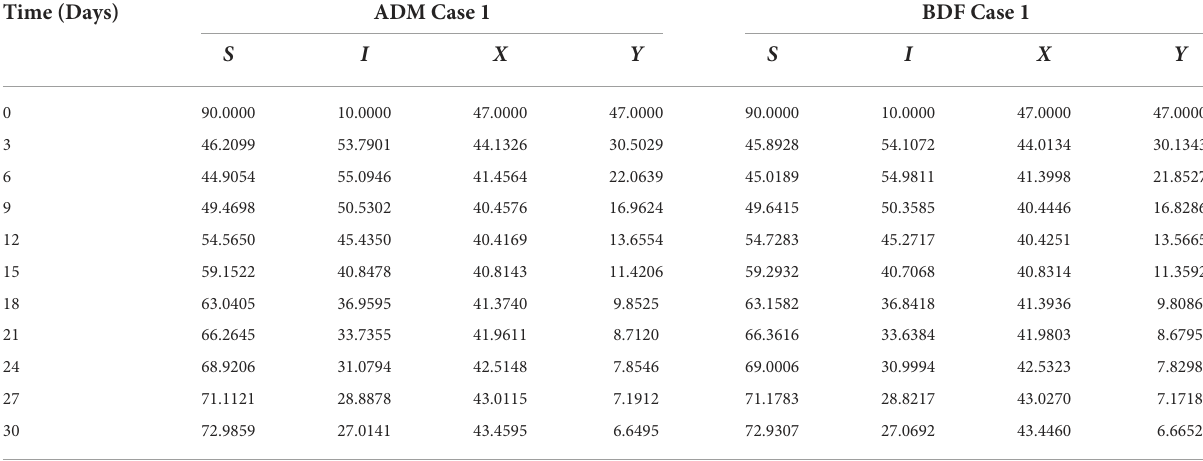
TABLE 3 Numerical outcomes of non-linear PVPMV model A for case-1 of scenario 2. Time (Days) ADM Case